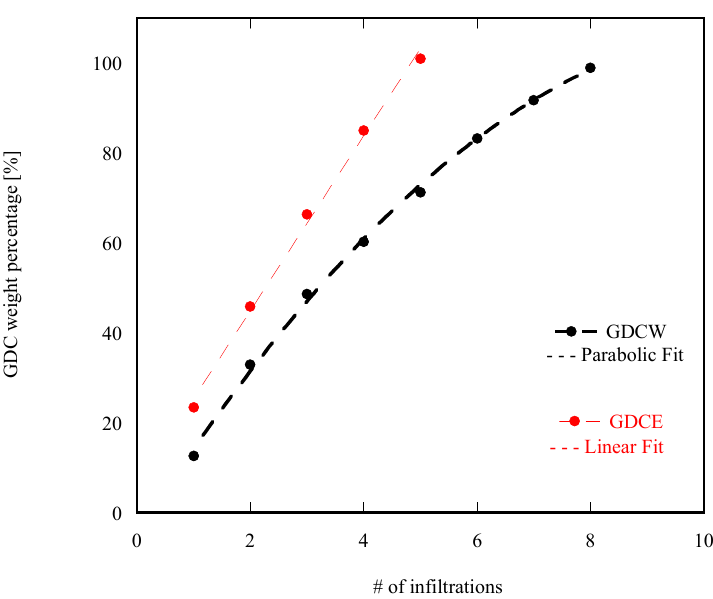
Figure 1. Weight gain of the lanthanum strontium chromium manganite / distilled water (LSCM / GDCW) and LSCM / pure ethanol (GDCE) electrodes as a function of the infiltration steps.